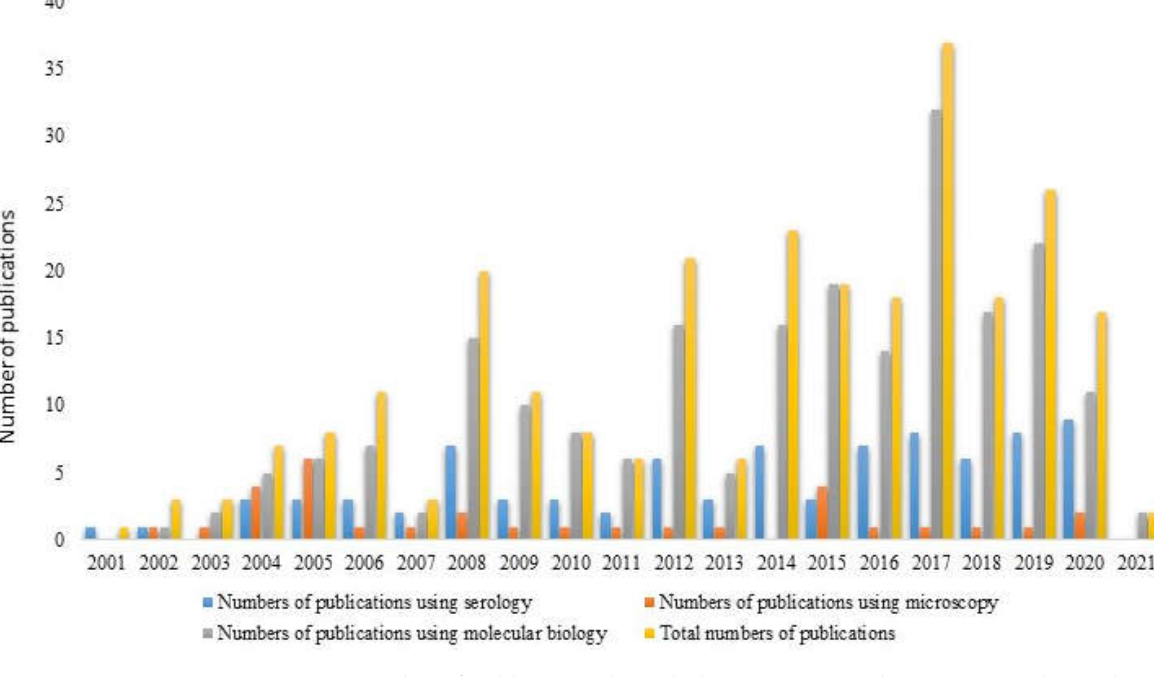
Figure 2. Number of publications through the years (2000–February 2021). The total number is indicated in yellow, and the other colors indicate the number of publications according to the detection method used (serology; microscopy; molecular biology).